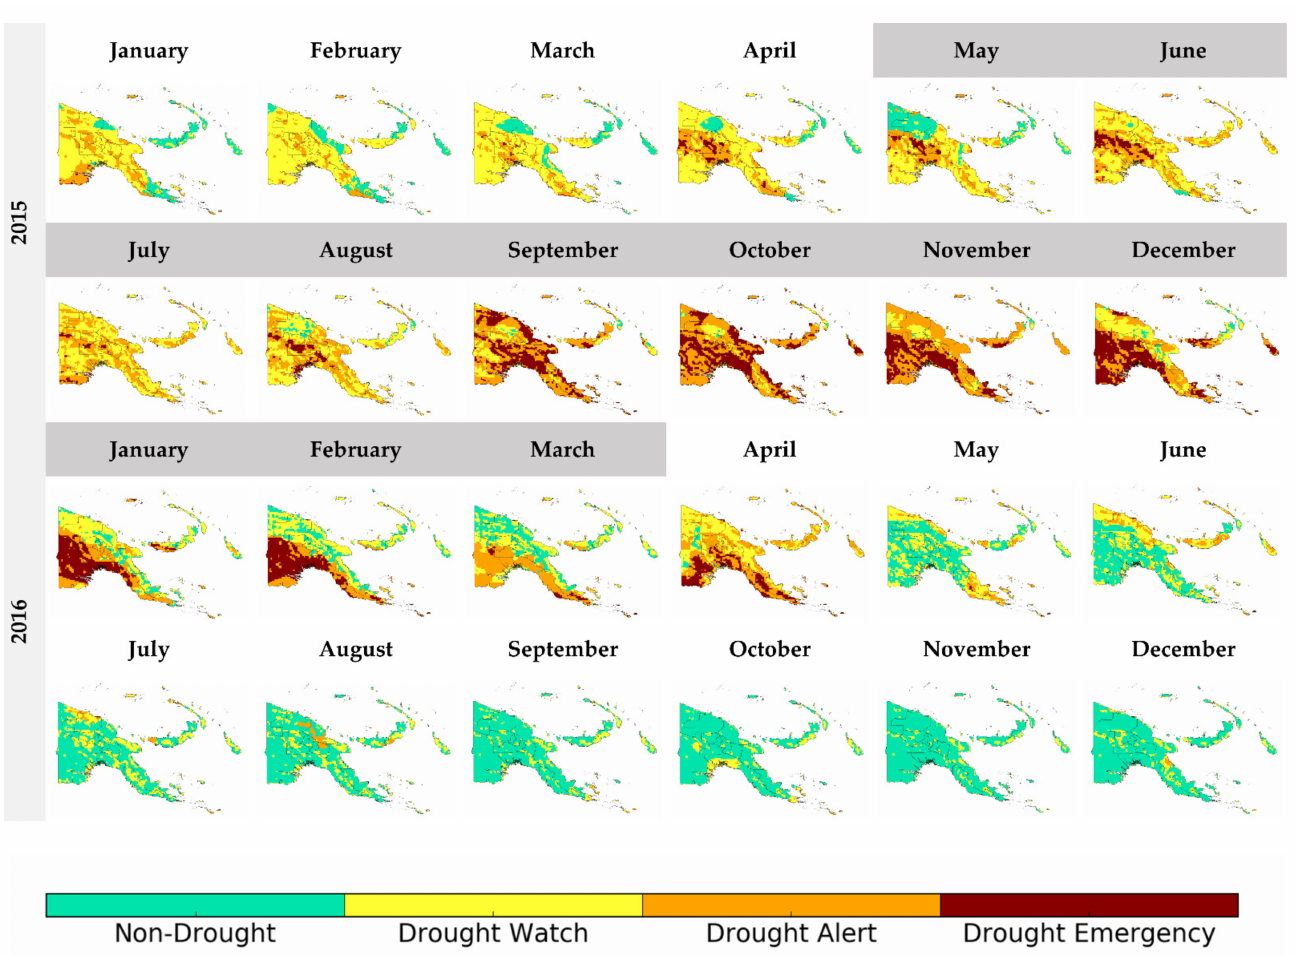
Figure 13. Drought I-EWS evolution of the 2015–2016 El Niño-induced drought in PNG. Dark grey bar indicates months when the El Niño was active as declared by the Bureau of Meteorology